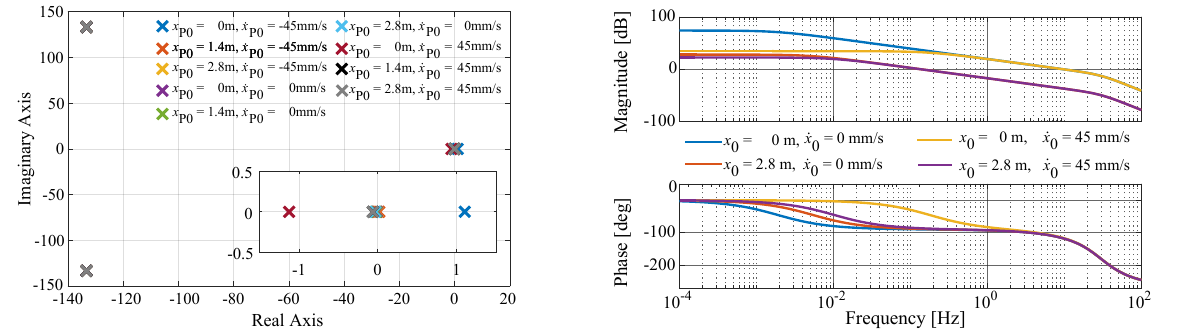
Figure 14: Open loop uncompensated Bode plot for p H q H,ref